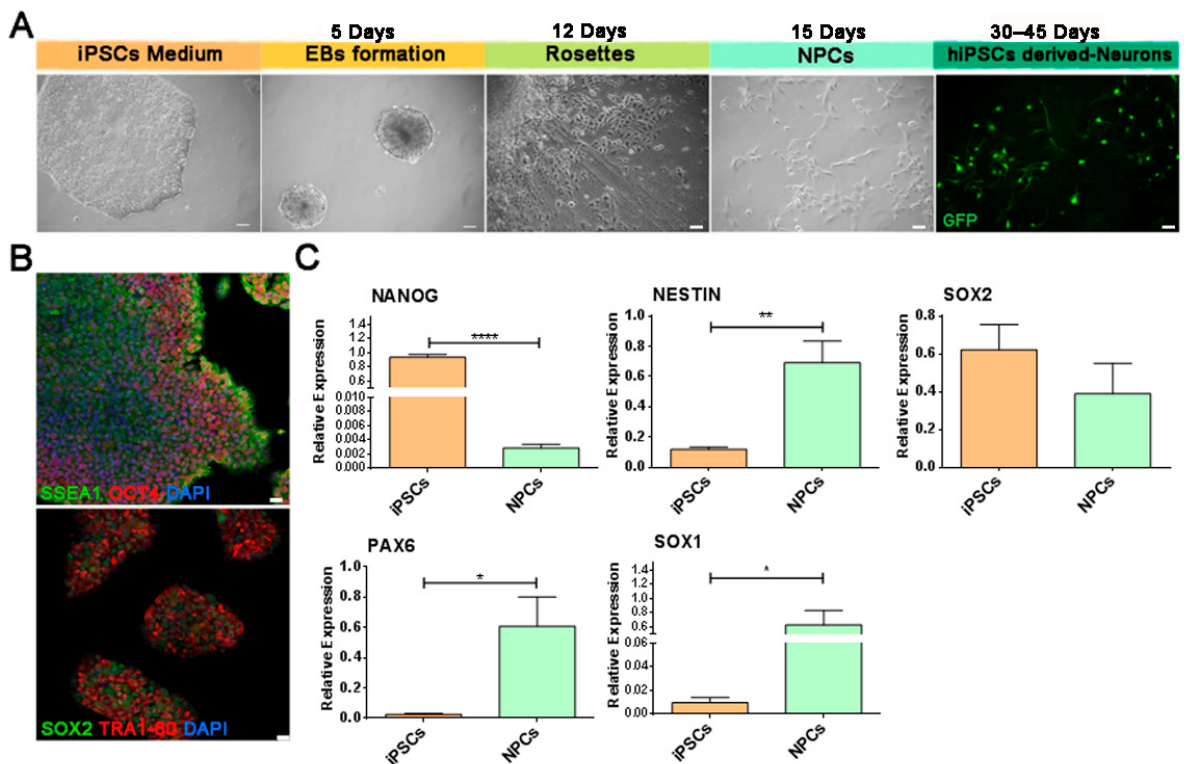
Figure 1. Differentiation from human-induced pluripotent stem cells (hiPSCs) to neuronal cells. ( A ) Schematic diagram showing the differentiation protocol: from left to right, hiPSCs, Embyoid Bodies (EBs), Neuronal Rosettes, sun-shaped structure with rays from the center (Rosettes), Neuroprecursors (NPCs) and hiPSC-derived Neurons. Scale bar 10 µ m. ( B ) Representative images of immunofluorescence (IF) of embryonic stem cell surface markers: Stage specific embryonic antigen-1 (SSEA1; green) and Octamer-binding transcription factor 4 (OCT4; red) ( top image), and SRY-Box Transcription Factor 2 (SOX2; green) and T cell receptor alpha locus 1-60 (TRA-1-60; red) ( bottom image). Cells were stained with nuclear marker 4 ′ ,6-diamidino-2-phenylindole, DAPI (blue). Scale bar 10 µm. ( C ) RT-qPCR shows upregulation of Sox1 and Pax6 in NPCs, as compared to hiPSCs. Nestin and Sox2 involved in pluripotency and neuronal differentiation are expressed in NPCs and hiPSCs. Bar graphs show the mean values ± SEM of relative expression, at least n = 3 replicate for each group. * p < 0.05, ** p < 0.01, **** p < 0.0001, by one way ANOVA, Bonferroni’s multiple comparisons.